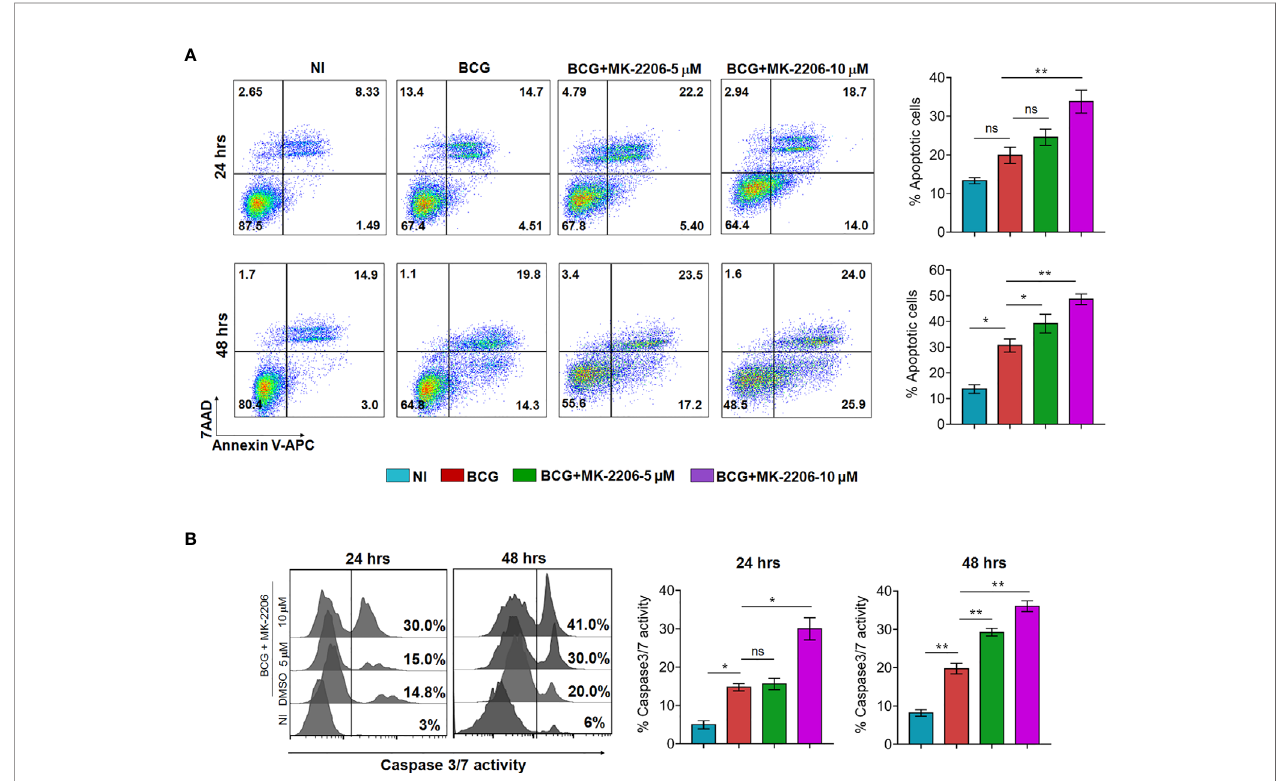
FIGURE 1 | MK-2206 enhances apoptosis in BCG infected macrophages. J774A.1 macrophages were infected with BCG (MOI ~ 10) and subsequently treated with different concentrations of MK-2206 (5 or 10 m M) for 24 and 48 h. Subsequently, macrophages were harvested at the indicated time points and assessed for apoptosis induction and caspase 3/7 activation. (A) Representative dot plots show the frequency of apoptotic cells (revealed by the sum of Annexin V + /7AAD + cells) at 24 and 48 h post MK-2206 treatment. Histograms depict the percentage of apoptotic cells at 24 and 48 h upon the indicated treatments. The values are presented as mean ± SEM of two experiments performed in triplicates. (B) To evaluate caspases activation, cells were stained with 2 m M of cell event caspase-3/7 green detection reagent and the samples were analyzed by fl ow cytometry. Histograms show representative data from two experiments performed in triplicates. The data shown is mean ± SEM obtained from two experiments performed in triplicates. Statistical differences were obtained between the indicated groups *p < 0.05; **p < 0.01; ns, non-signi fi cant; NI,